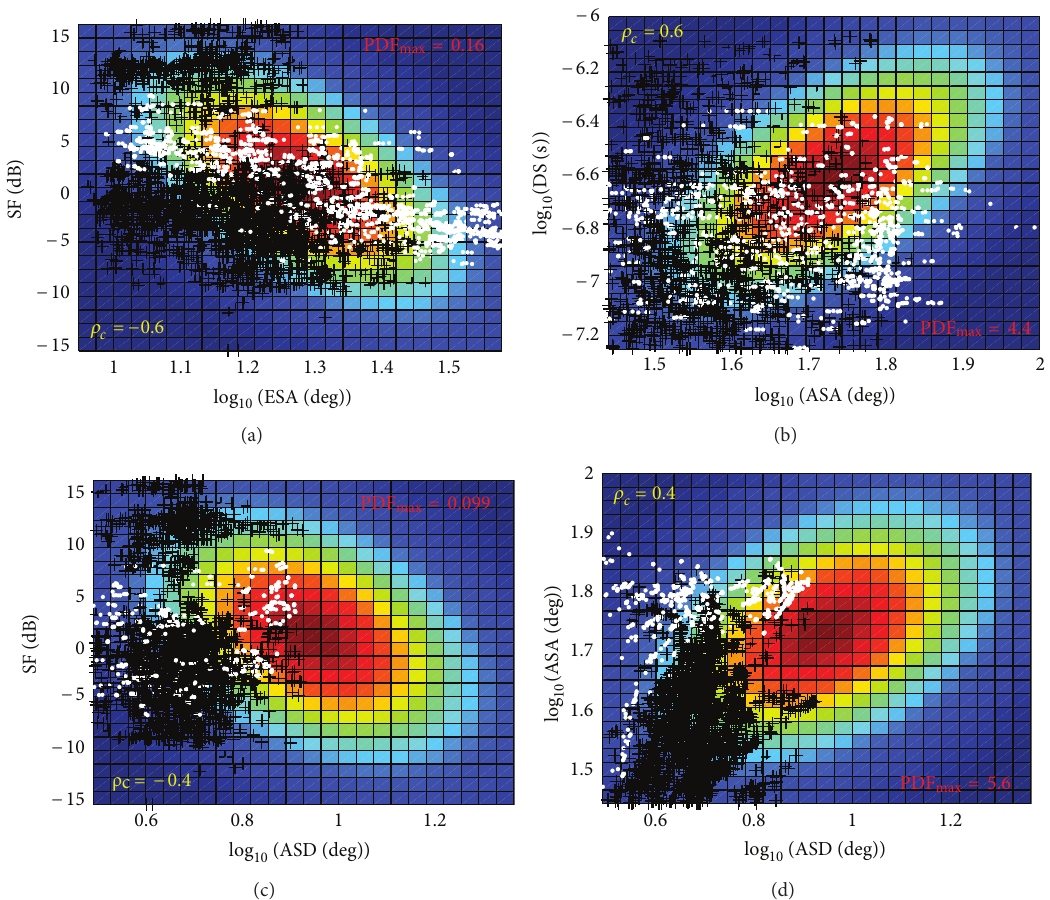
Figure 8: Comparison of joint WINNER C2 2D PDFs with the LSP realizations from Ilmenau (black pluses) and Dresden (white dots), for NLoS propagation.